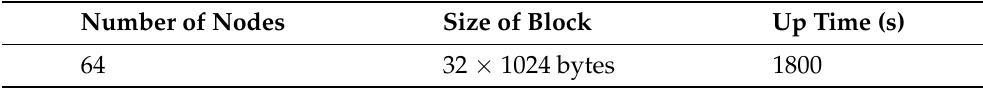
Table 4. Setup Components.